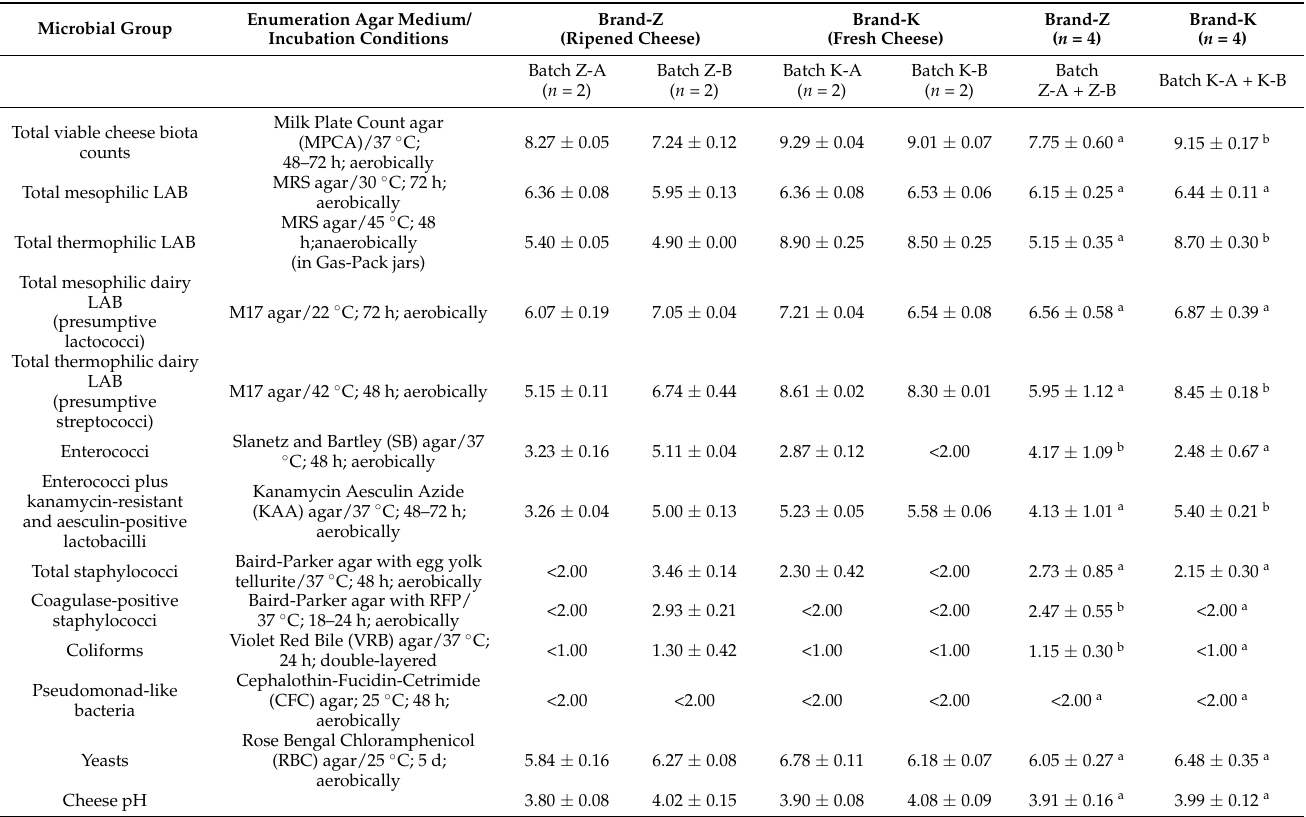
Table 2. Microbial populations (log CFU/g) and pH values of four retail individual batches of Galotyri PDO cheeses produced by two traditional dairy SMEs (Brand-Z and Brand-K) and distributed in the Epirus market with (Brand-Z; ripened cheese) or without (Brand-K; fresh cheese) a preceding ripening